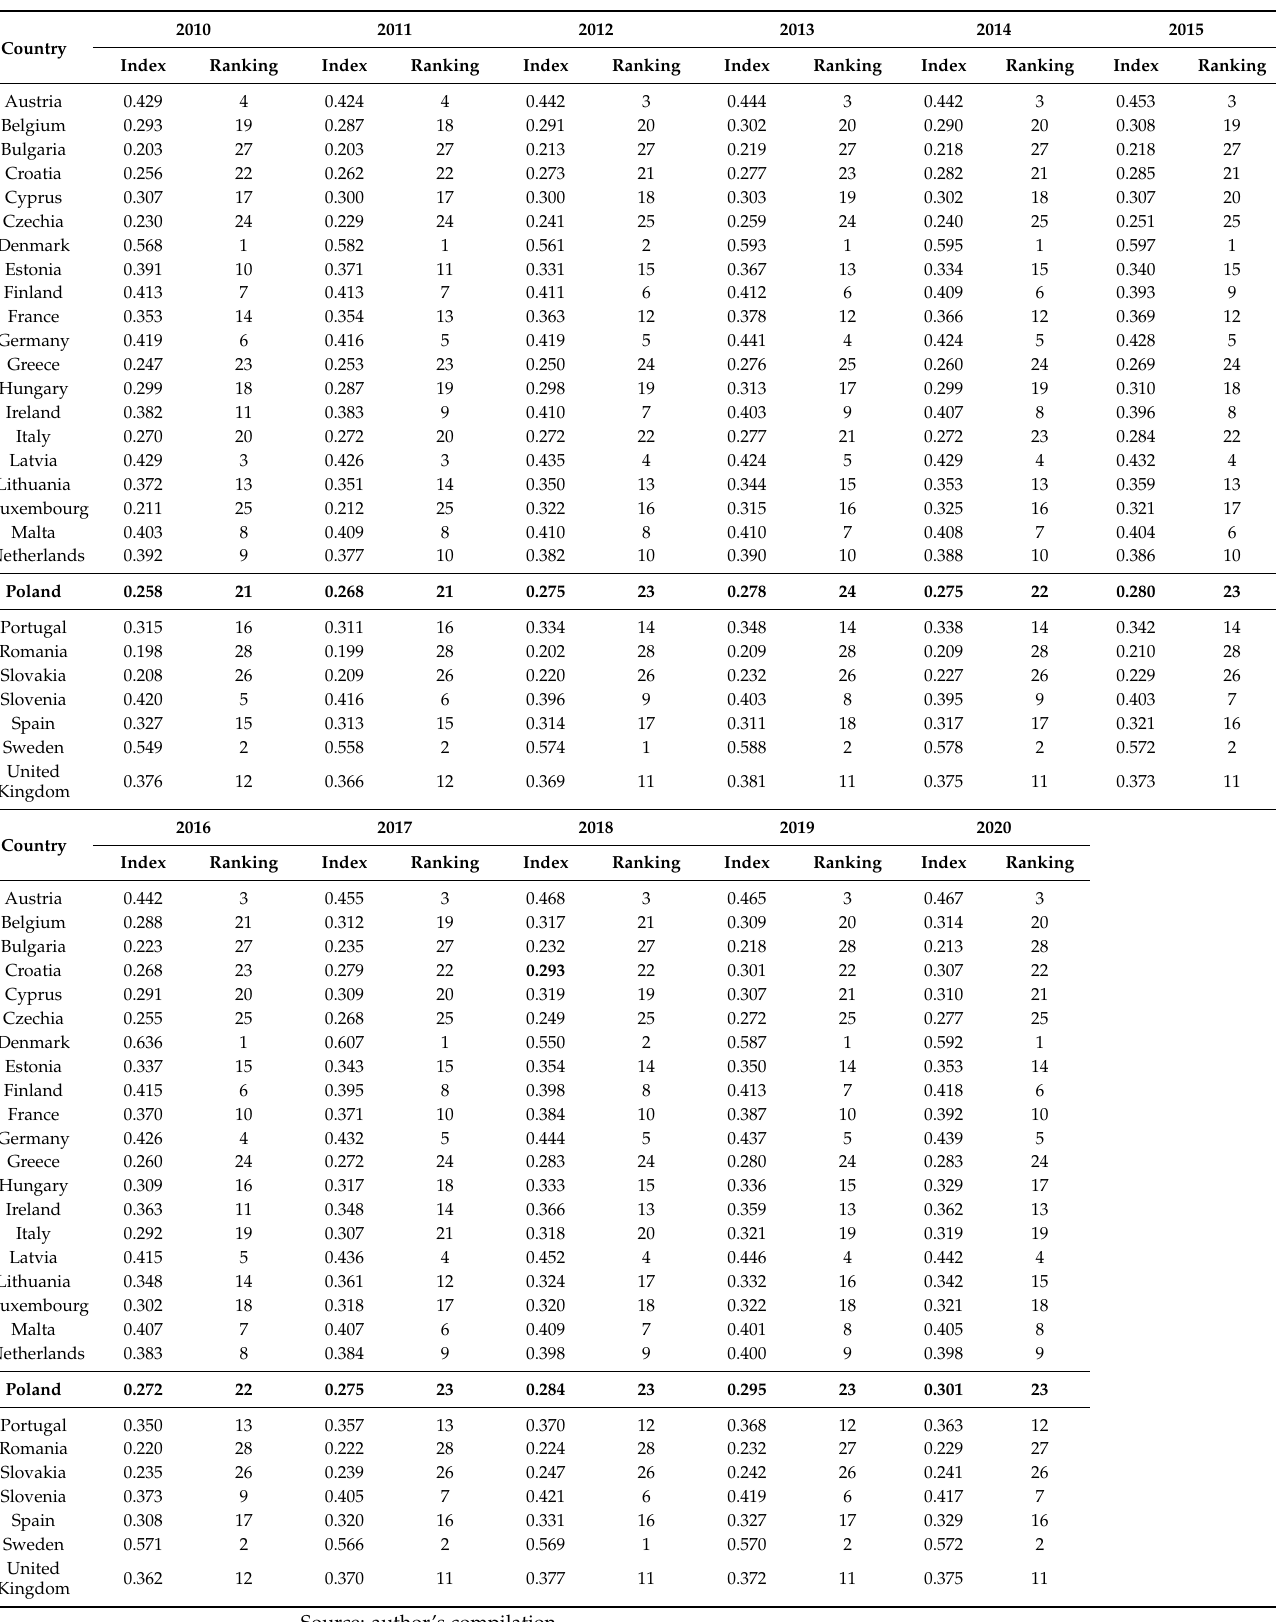
Table 4. The value of EI for EU-28 along with the EU-28 ranking according to EI in